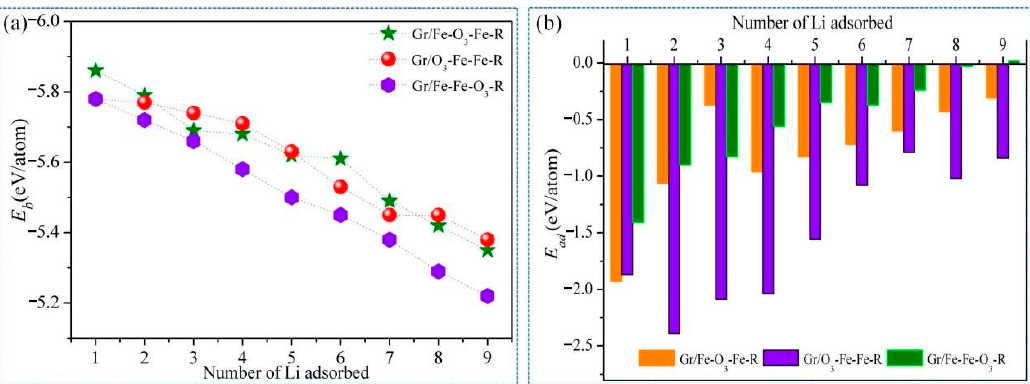
Figure 3. ( a ) Binding energy ( E b ) and ( b ) adsorption energy ( E ad ) of the Li n (Gr/Fe-O 3 -Fe-R), Li n (Gr/O 3 -Fe-Fe-R), and Li n (Gr/Fe-Fe-O 3 -R) systems.